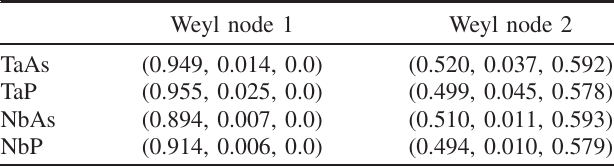
TABLE I. The two nonequivalent Weyl points in the xyz coordinates shown in Fig. 1(b). The position is given in units of the length of Γ - Σ for x and y and of the length of Γ - Z for z . Weyl node